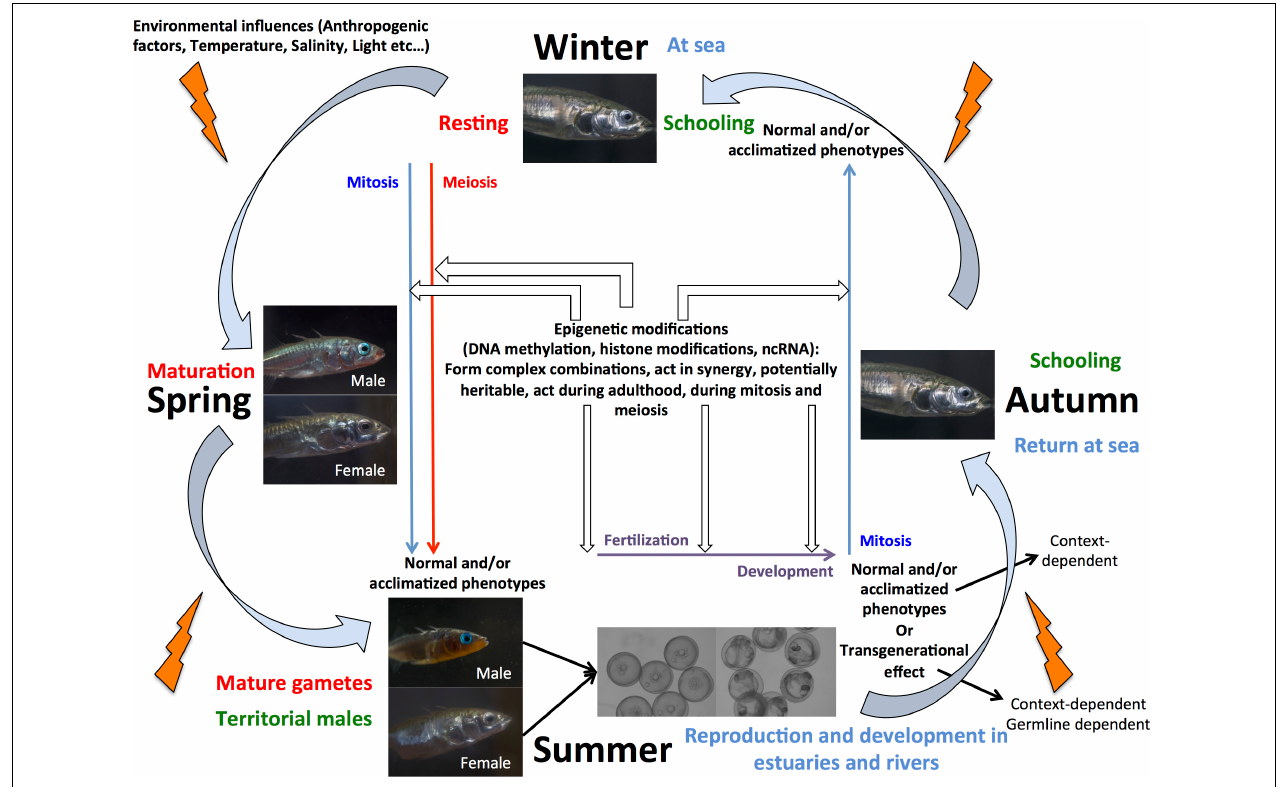
FIGURE 1 | Schmatic view of marine stickleback life cycle illustrating the potential for this species as a model to elucidate the synergistic role of epigenetic mechanisms in aquaculture and eco-evolutionary